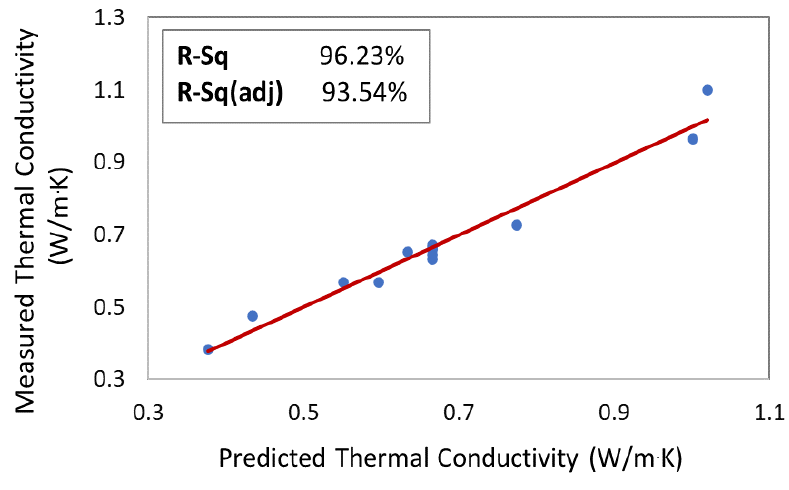
Figure 4. Parity plot that represents the measured thermal conductivity (blue dots) vs. the predicted one (red trendline). one (red